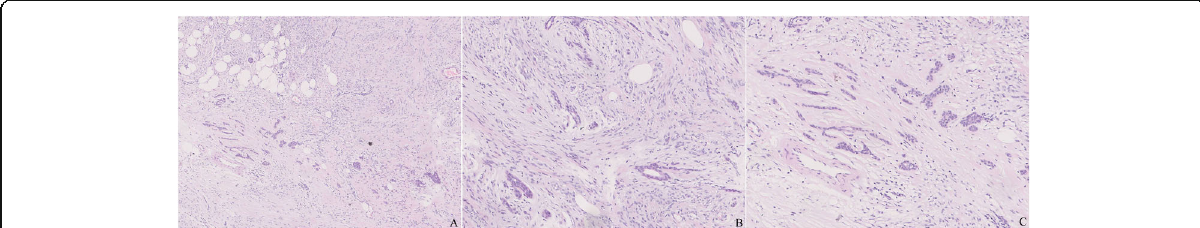
Fig. 3 a . There were a few bland epithelial elements with formation of tubule or solid structures in a haphazardly infiltrating manner. b . The tubules, composed of two-layer cells, resembled normal mammary glands. c . The solid nests were composed of uniform cells without distinct squamous